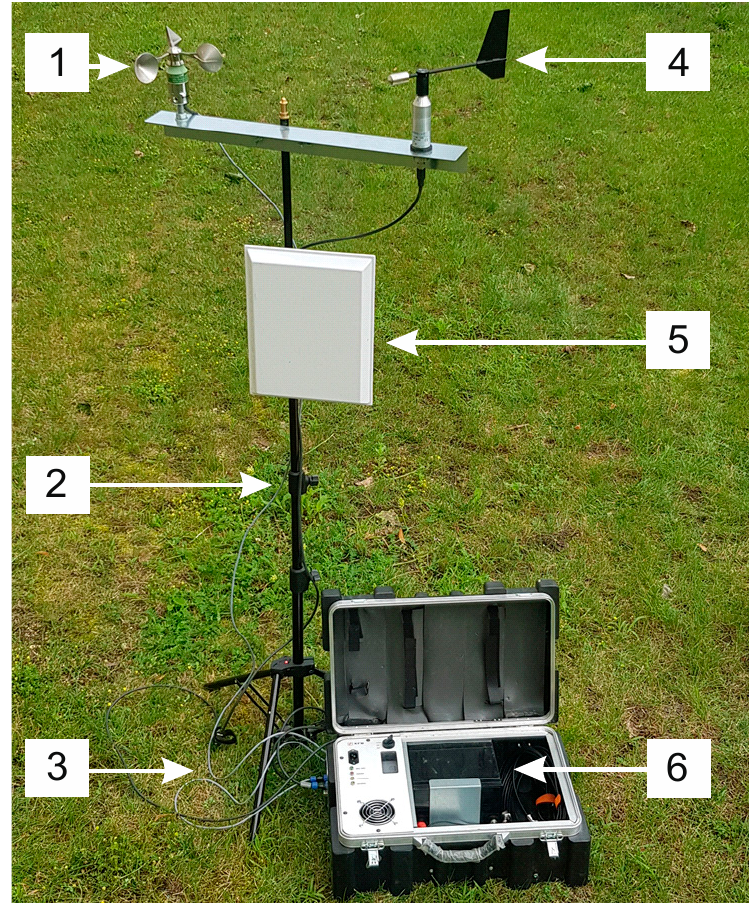
Figure 3. View of measuring station, where: 1—anemometer; 2—telescopic measurement tripod; 3—connector cables; 4—wind vane; 5—directional antenna and 6—measuring case.